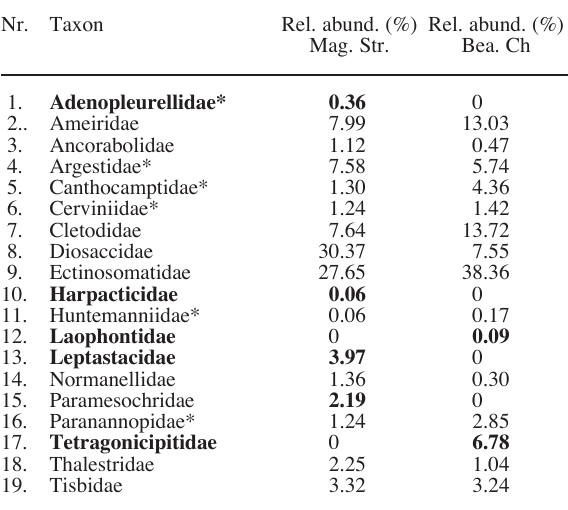
T ABLE 2. – List of harpacticoid families found in the sampled area, including relative abundances (rel. abund.) (in %) of each taxon in the Magellan Straits and/or the Beagle Channel respectively. Taxa restricted to one of the areas indicated by bold names and data. Families marked by an asterisk* are new for the Chilean marine